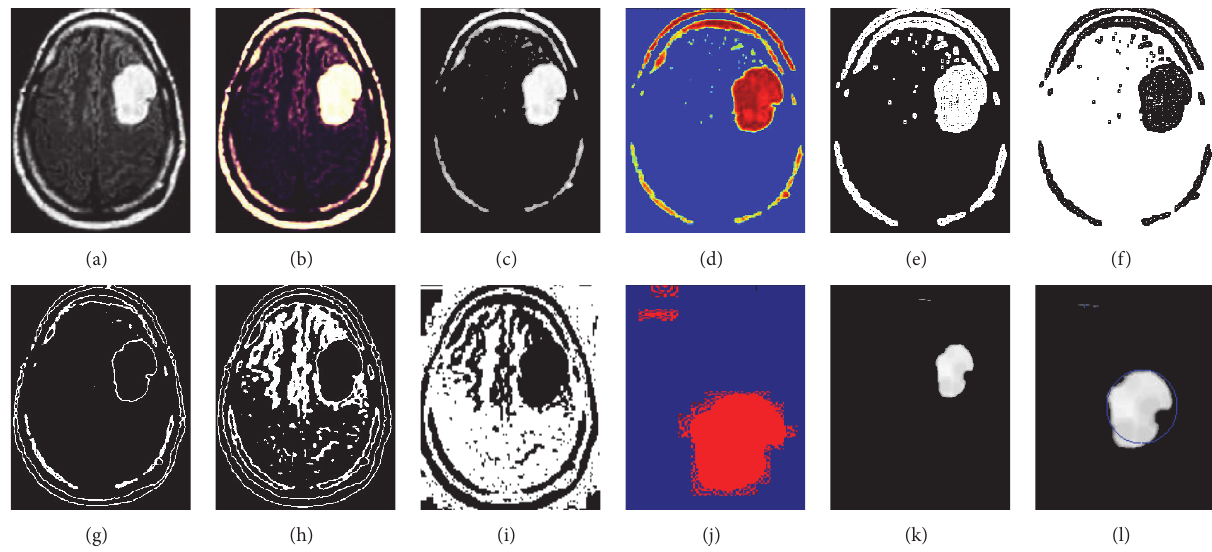
Figure 3: Segmented and area extracted result of brain MR image. (a) Original image. (b) Enhanced image. (c) Skull-stripped image. (d) Wavelet transpose image. (e) Intense segmented image. (f) Inverse intense image. (g) Gray matter. (h) White matter. (i) CSF. (j) Dice overlap image. (k) Eroded image. (l) Area extracted